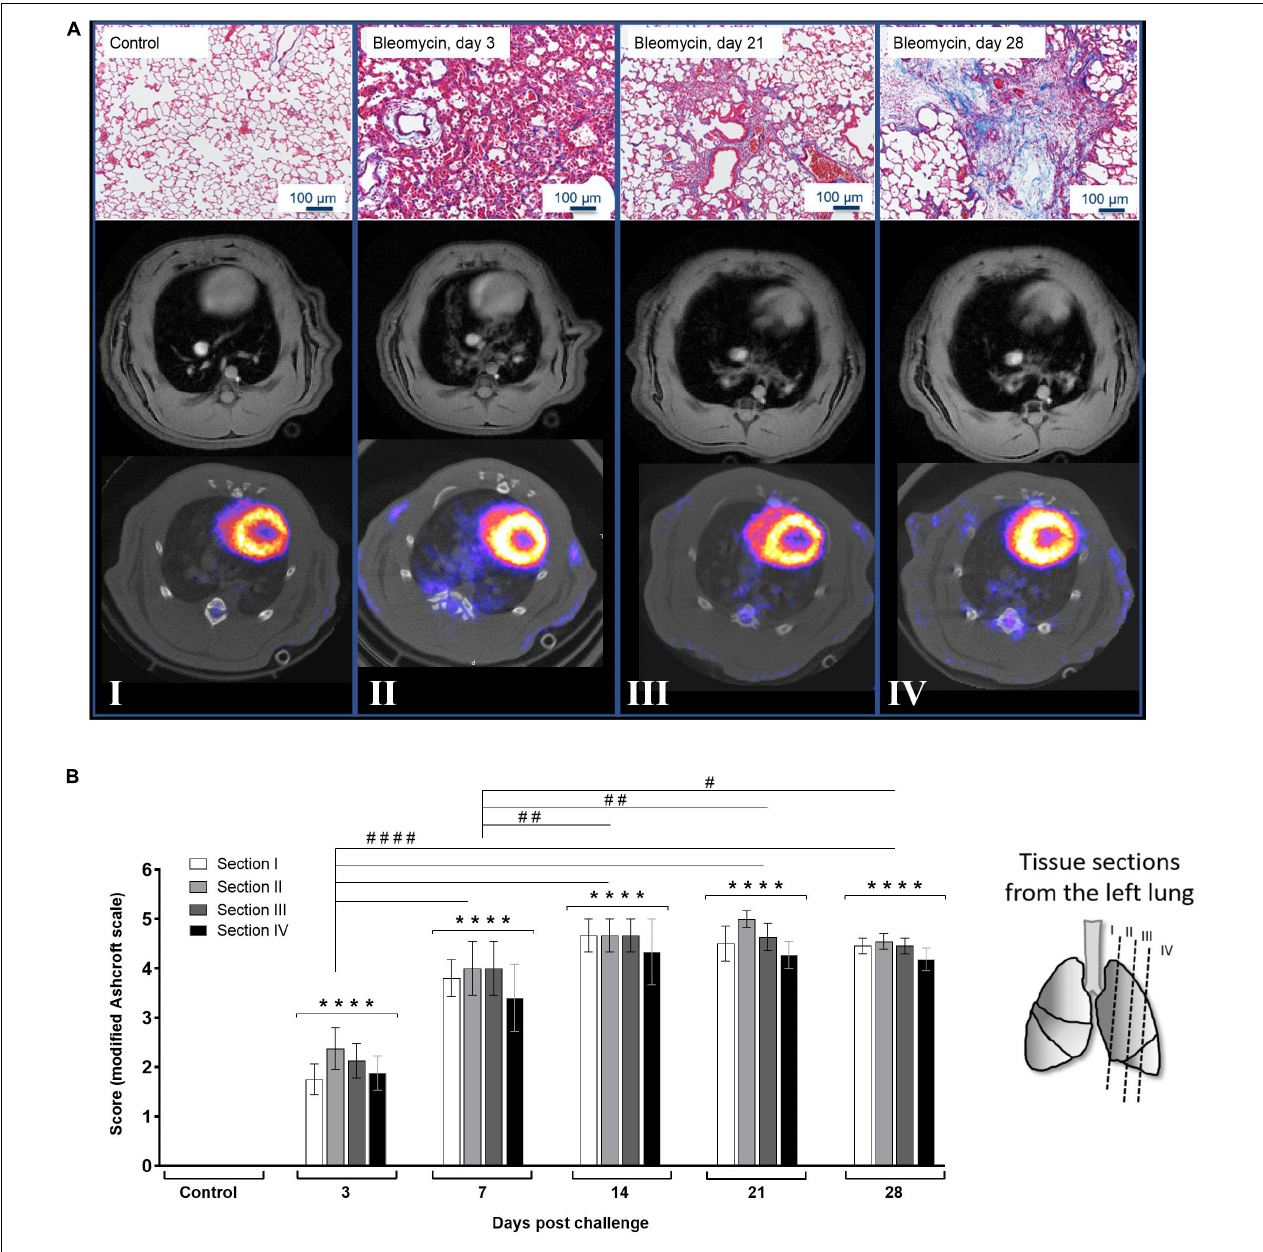
FIGURE 3 | Histology and lung images at various time points post bleomycin challenge. (A) Representative images from Masson’s-Trichrome staining presented at baseline/control (I), day 3 (II), day 21 (III), and day 28 (IV) post bleomycin challenge, in association to MRI- and PET/CT images of the lungs. All images acquired during the imaging scan sessions were used for quantitative analysis, where data were extracted within the lung-ROI, which is defined in Supplementary Figure S2 . (B) Scoring of the histological staining where histological sections were collected from different positions in the left lung lobe of the sacrificed rats. After applying the modified Ashcroft fibrosis score (scale ranging from 0 to 8), the scoring results indicate fibrotic progression over time while infiltration of inflammatory cells ceased and was cleared over time. Statistical comparison between sections at each time point was not significantly different, indicating even distribution of injury throughout all lung sections in each animal. Scoring variation between groups was compared and indicated by **** when p < 0.0001 when comparing bleomycin towards the saline control. The comparison of various time points between bleomycin-challenged groups is expressed as # when p < 0.05; ## when p < 0.01 and #### when p <